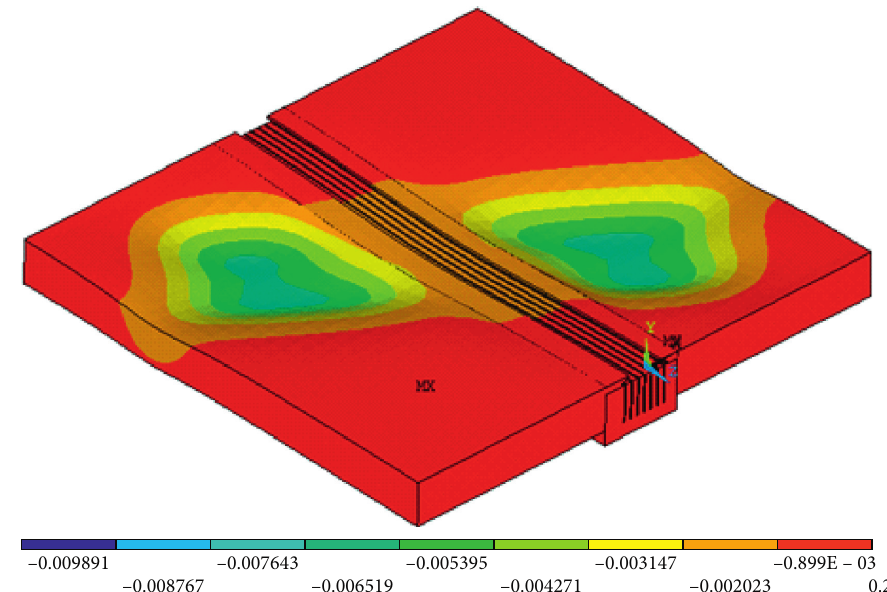
Figure 7: Numerical simulation of settlement